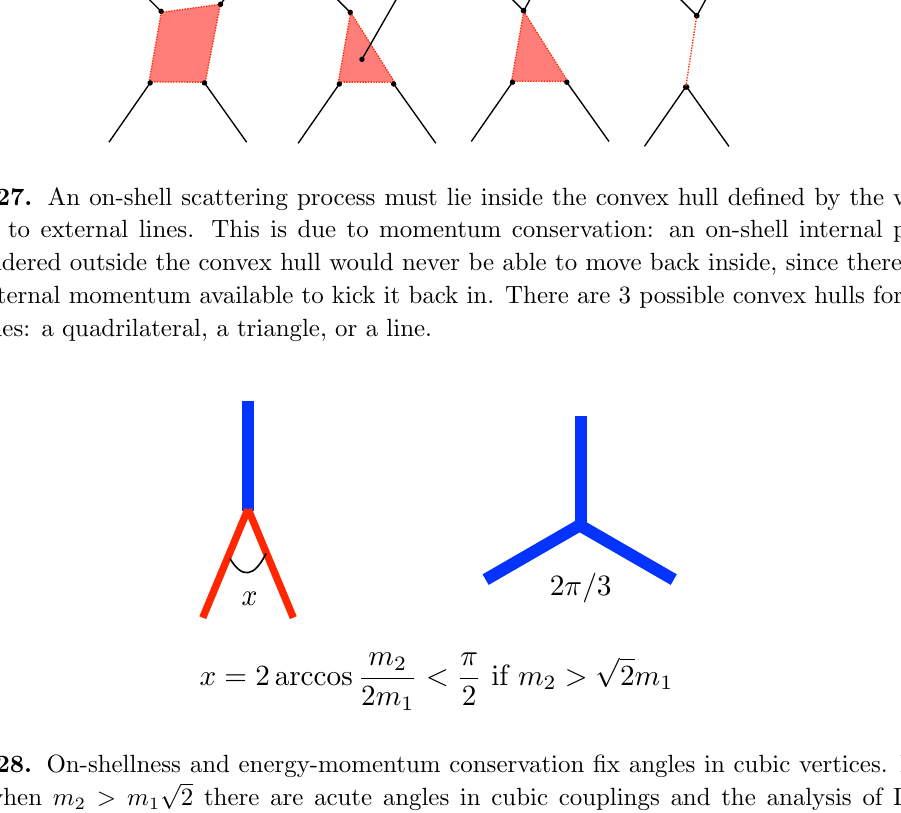
Figure 28. On-shellness and energy-momentum conservation (cid:12)x angles in cubic vertices. Impor- tantly, when m 2 > m 1 p 2 there are acute angles in cubic couplings and the analysis of Landau singularities becomes more